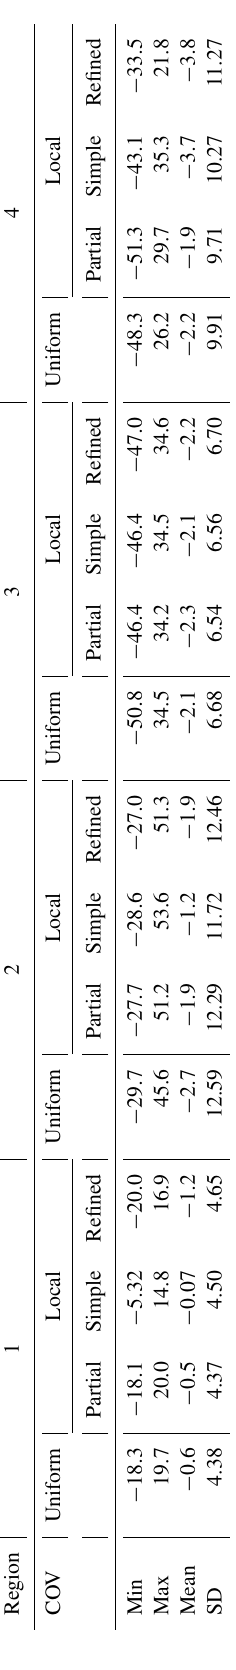
Table 9. Parameters of the improved local COV modeling in each